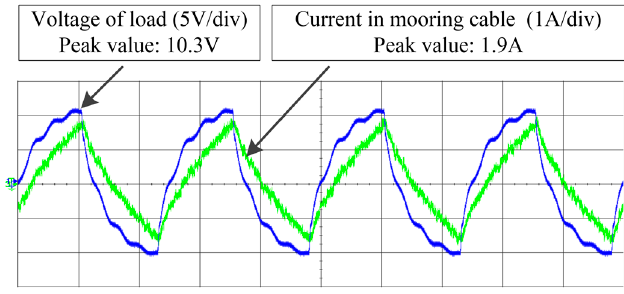
Figure 16. Experiment of original parameters. Table 3. Experiment results.